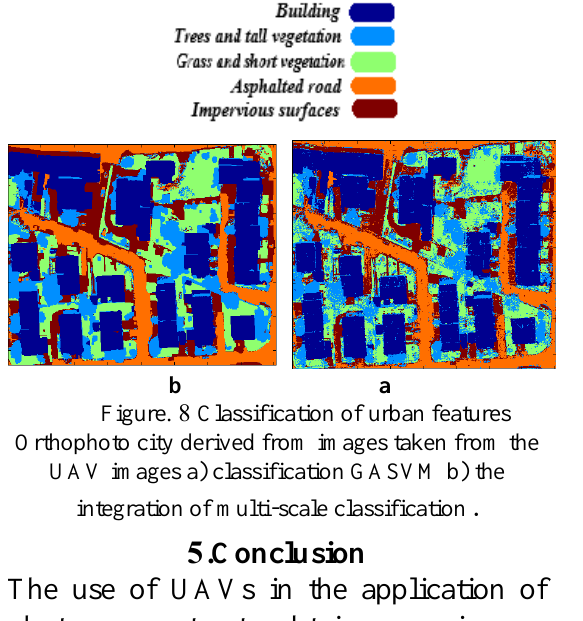
Figure. 8 Classification of urban features Orthophoto city derived from images taken from the UAV images a) classification GASVM b) the integration of multi-scale classification